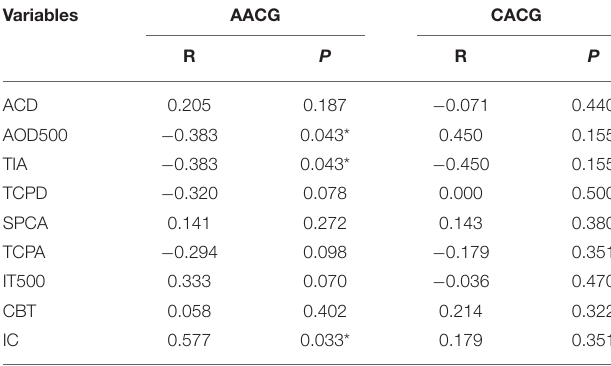
TABLE 3 | The changes of preoperative and 1-year postoperative UBM parameters.